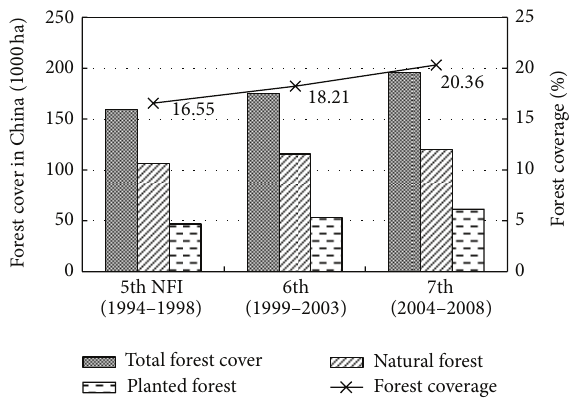
Figure 1: Changes of forest cover and coverage over time in